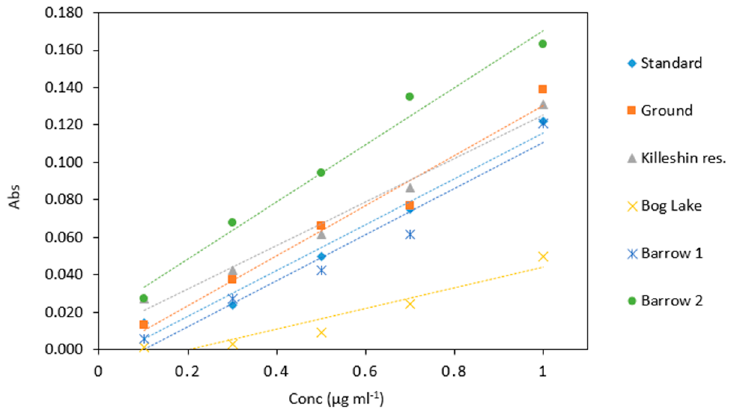
Figure 10. Comparison of arsenic samples (0.1–1 µ g mL − 1 ) analyzed in several water matrices. All measurements were carried out in triplicate ( n = 90).